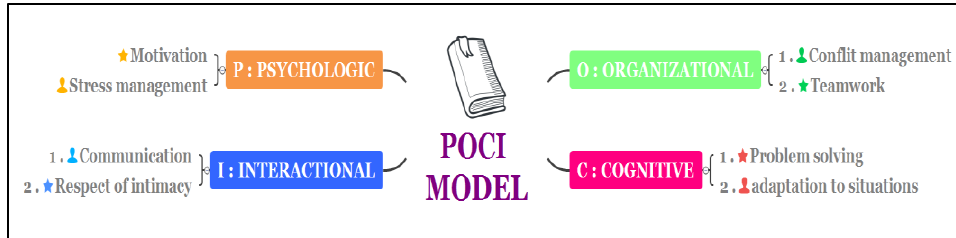
Figure 2. The essential non-technical skills according to the dimensions of POCI skills.